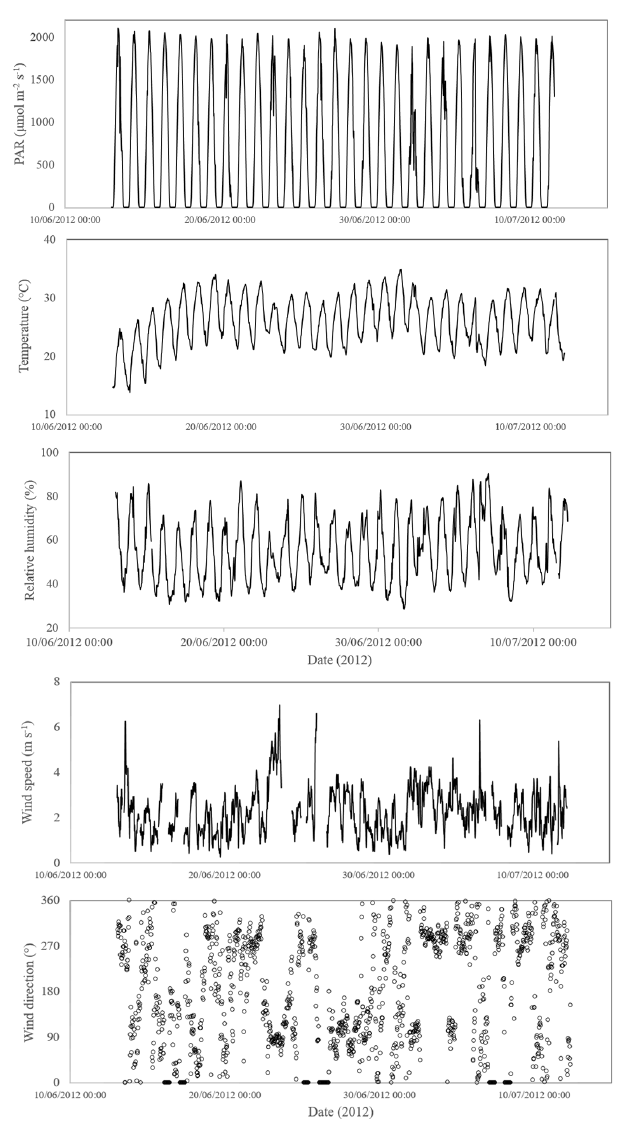
Figure 1. Time series of meteorological conditions recorded over the campaign period. From top to bottom: PAR (µmolm − 2 s − 1 ) , air temperature ( ◦ C), relative humidity (%), wind speed (ms − 1 ) and wind direction ( ◦ ).